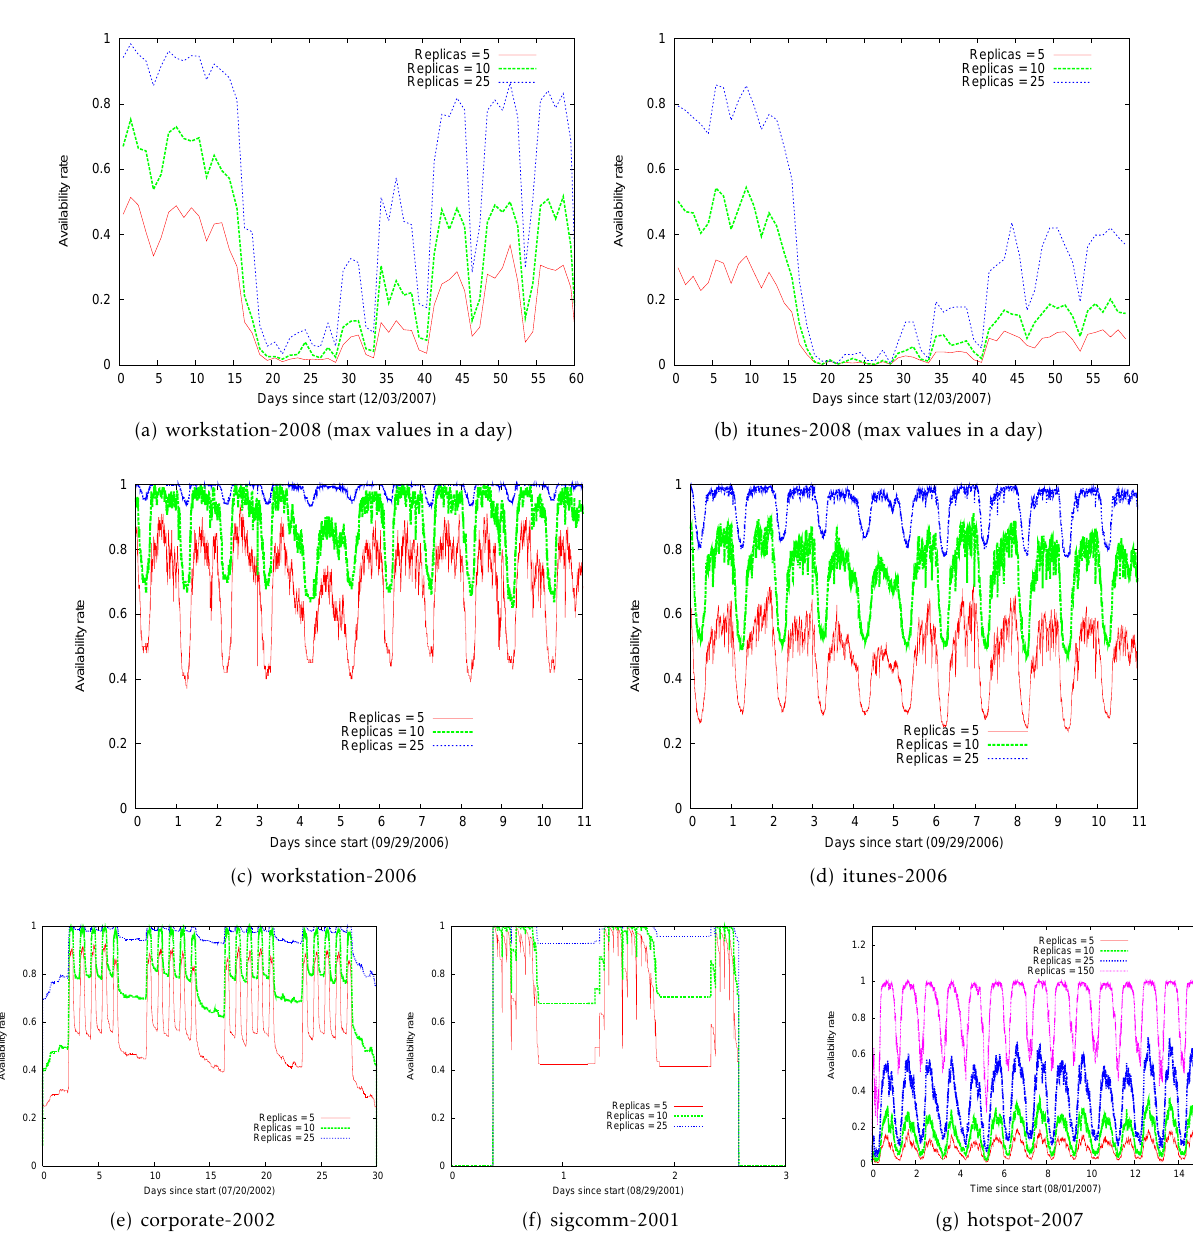
Figure 9. Improving availability of local updates for other group members by replicating objects among wireless